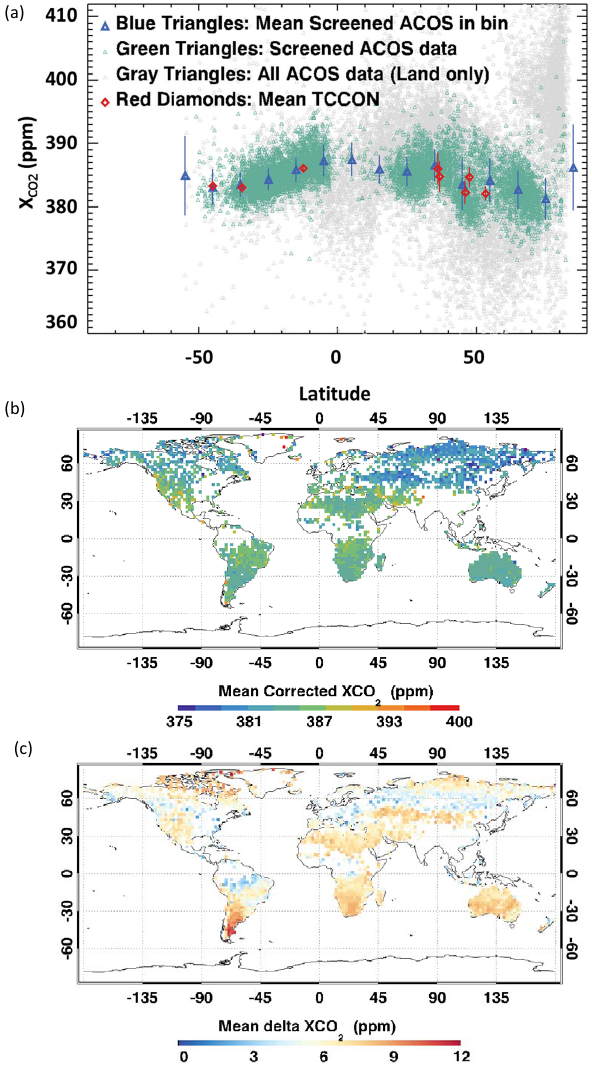
Fig. 13. ACOS GOSAT 2.8 retrievals from July 2009, corrected using the empirical regression formula developed by Wunch et al. (2011b). (a) Corrected B2.8 soundings that pass the nominal B2.8 screens (green triangles) and their averages in 10 ◦ zonal bins (blue triangles) are compared to TCCON measurements (red dia- monds). (b) Spatial map of corrected B2.8 soundings. (c) Differ- ences between the X CO retrievals shown in Fig. 13b and the raw 2 B2.8 retrievals shown in Fig. 1. After removing a ∼ 7ppm global offset, the empirical correction yields reduced X CO over the trop- 2 ics and northern mid-latitudes and higher values elsewhere. The combination of relatively large solar zenith angles and the presence of snow and ice cover in Patagonia contribute to the large positive air mass and blended albedo corrections